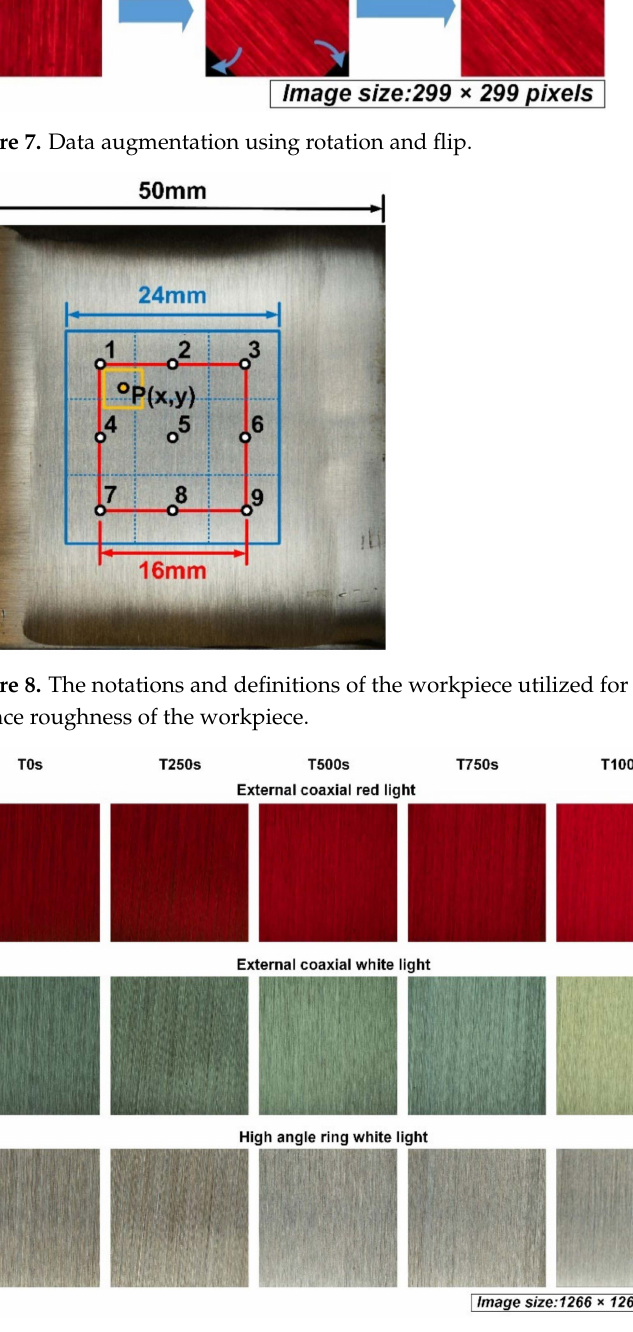
Figure 9. The images of the workpieces ground by abrasive belts with different degrees of